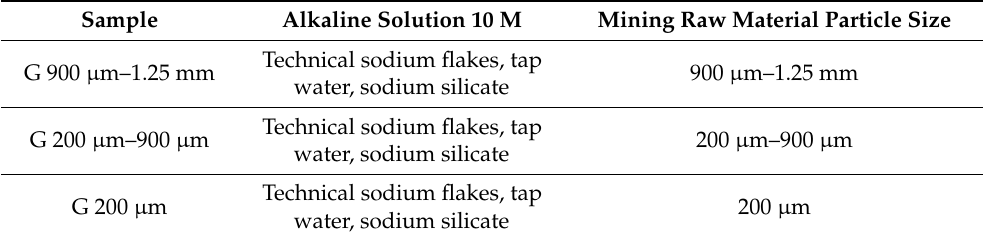
Table 2. Composition of the prepared geopolymers.